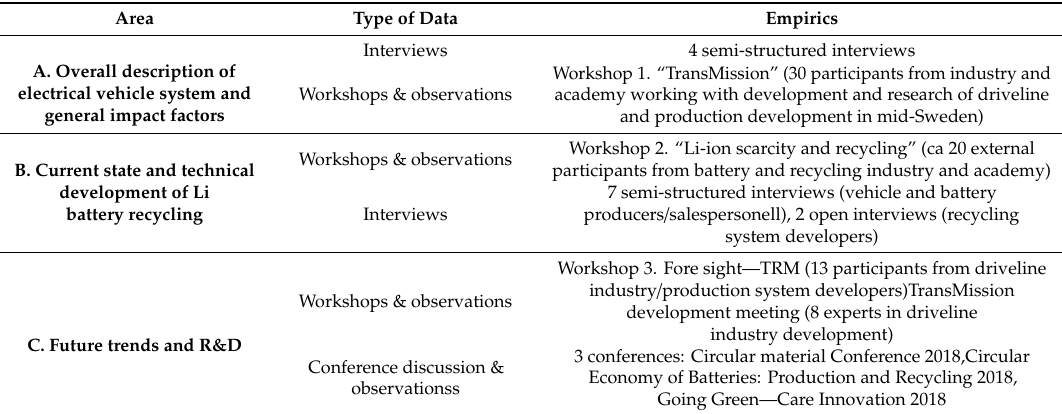
Table 1. Empirical data